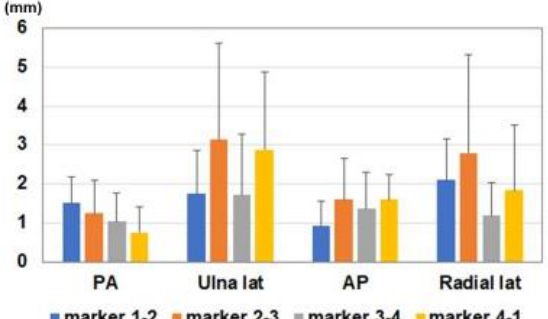
Figure 5. Differences between measured values on the fluoroscopic image and 3D bone image for each marker. Blue bar: difference of the measurement between markers 1-2. Orange bar: difference of the measurement between markers 2-3. Gray bar: difference of the measurement between markers 3-4. Yellow bar: difference of the measurement between markers 4-1.